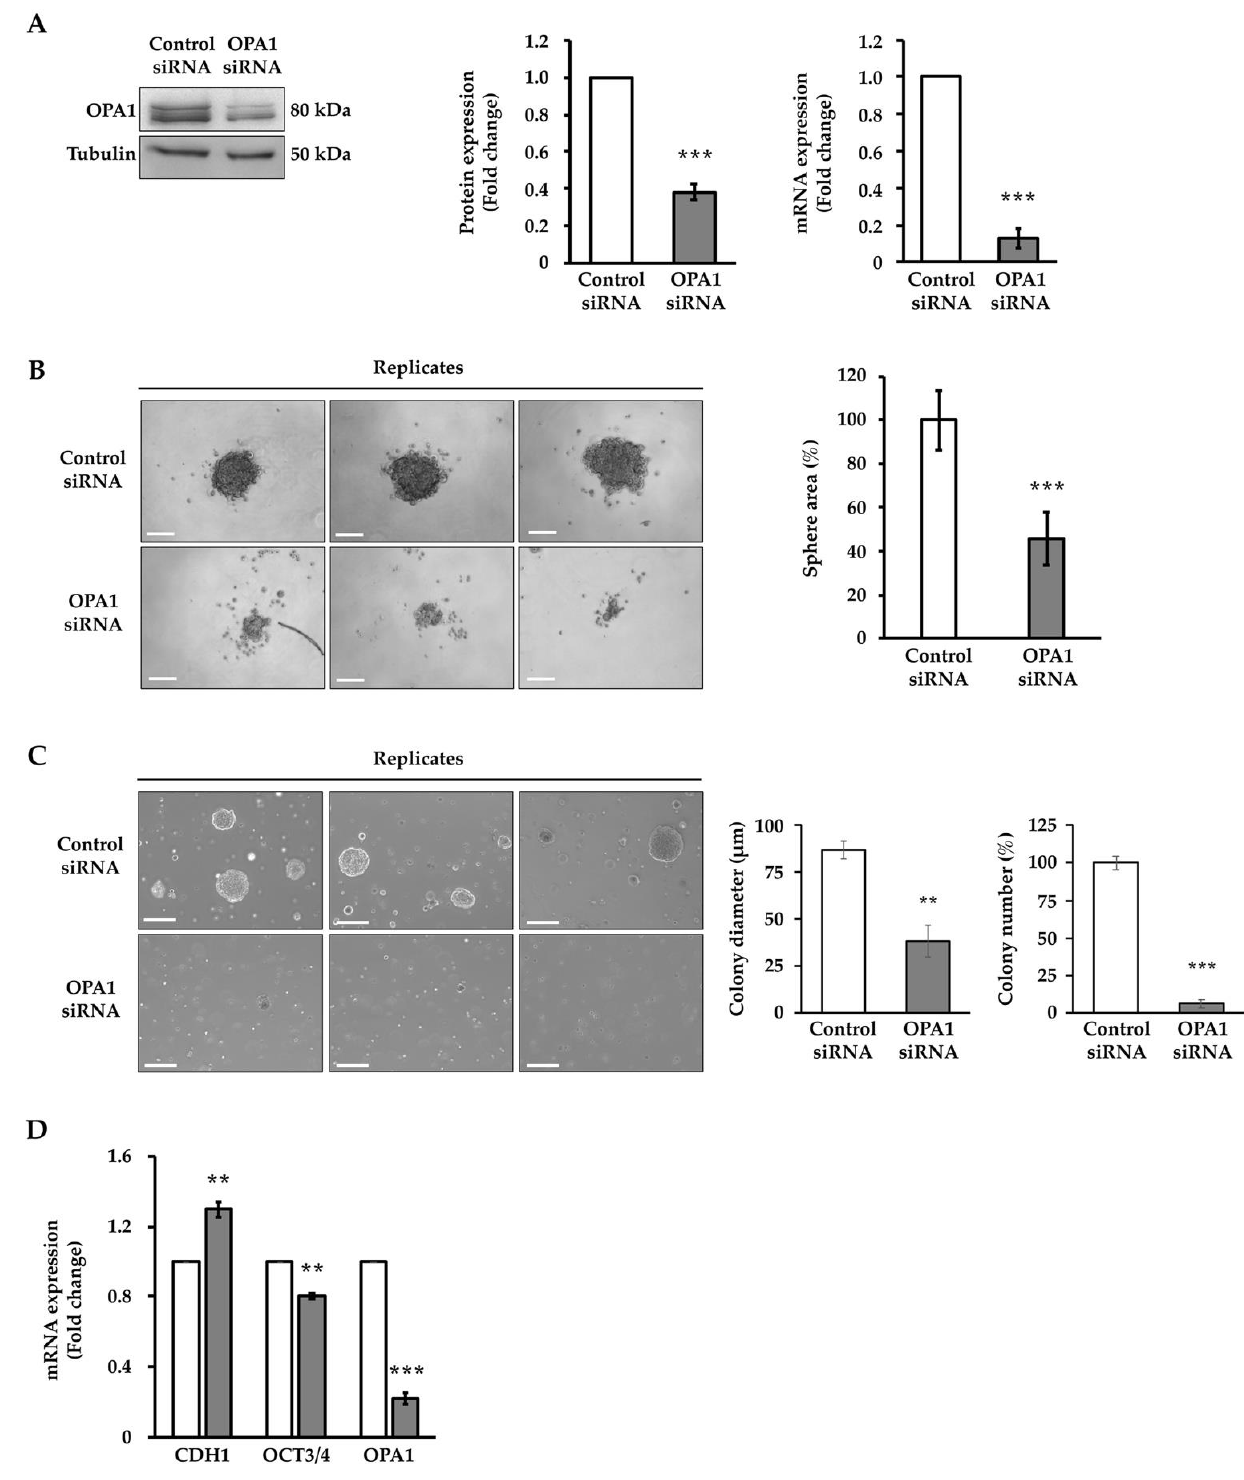
Figure 5. Knockdown of OPA1 reduces the sphere formation in Panc1 cells. ( A ) Protein and mRNA expression levels of OPA1 after its silencing in Panc1 parental cells: the left panel depicts a repre- sentative immunoblot against OPA1 in Panc1 cells after 72 h of transfection using OPA1 siRNA. The right panel shows the mRNA expression levels of OPA1 in Panc1 cells after 48 h of transfection using OPA1 siRNA. ( B ) After 48 of transfection with OPA1 siRNA, Panc1 cells were seeded in non- adherent Nunclon Sphera 96-well plates for 8 days. The left panel is the bright field microscopy image of the spheres in the control and silenced cells and the right panel is the quantification of the